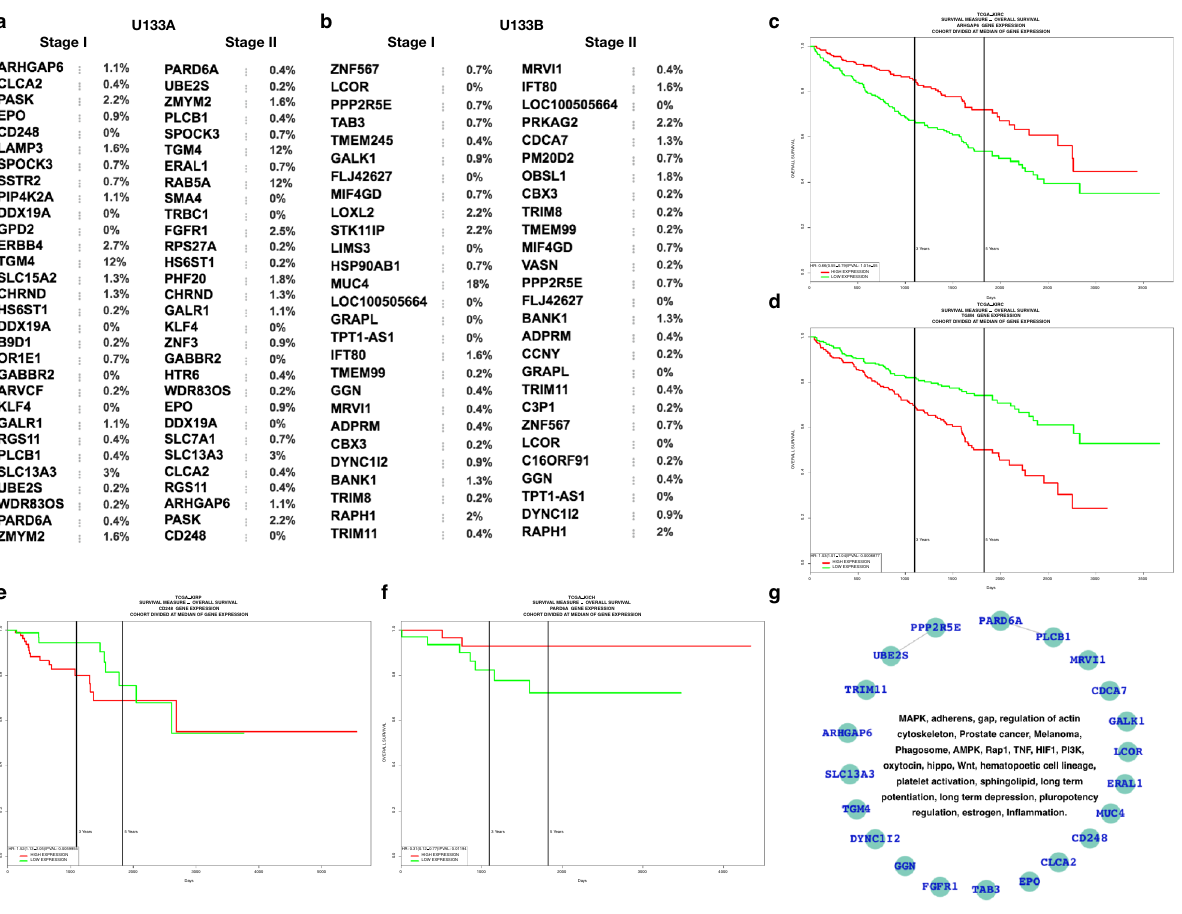
Figure 4. Clinical significance of the top ranked genes. ( a , b ) Top 30 (15 up and down) DEGs (based on fold change) with the rate of mutation in kidney renal clear cell carcinoma (TCGA) with their mutations. ( c – f ) Survival plots for the selected top ranked genes. ( g ) Network of the clinically significant genes and the associated pathways. Here, ( a ) and ( b ) were drawn by using cBioPortal, ( c – f ) by using PROGgeneV2 (http:// www. progt ools. net/ gene/ index. php), and ( g ) by